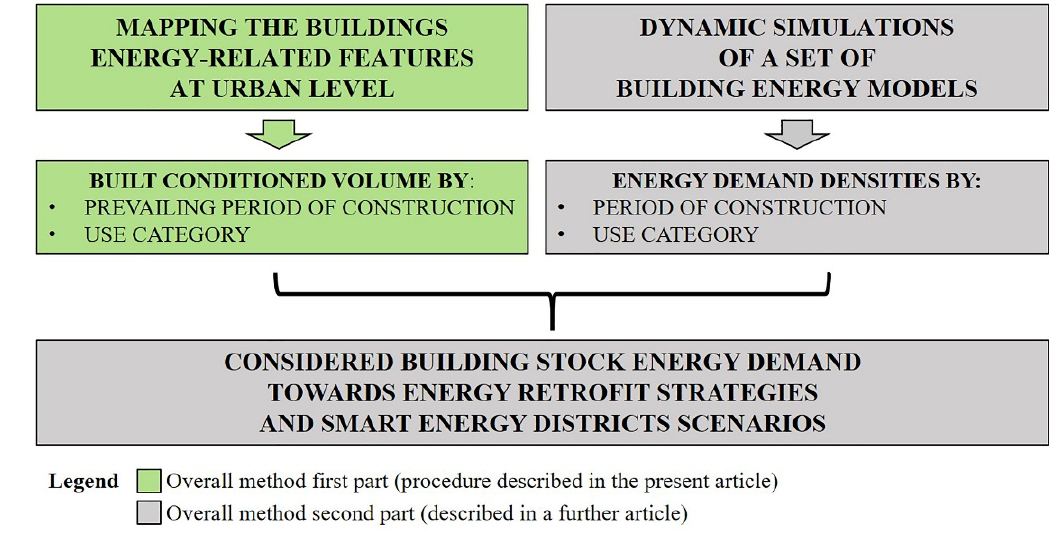
Figure 12. Diagram of the defined method for estimating urban building stocks’ energy demand.